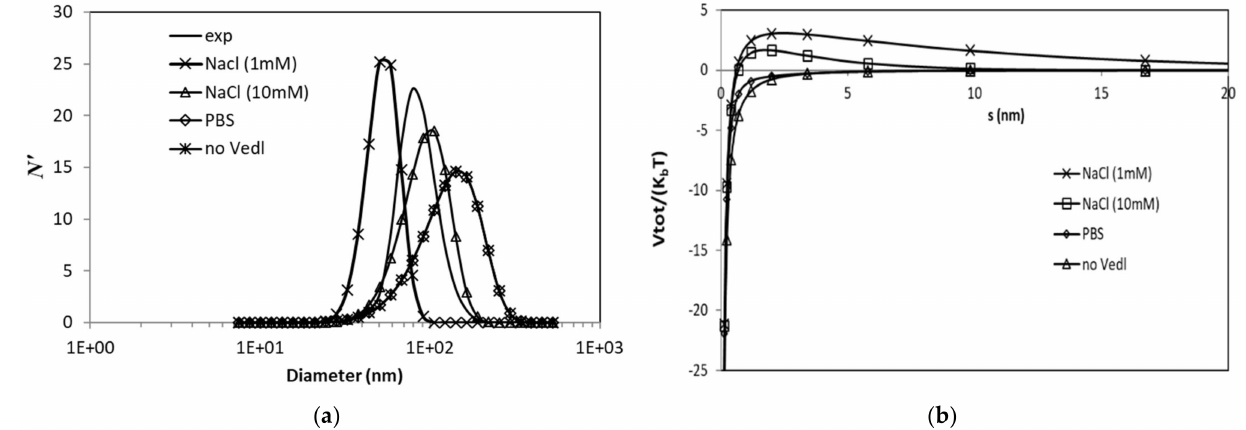
Figure 6. Effects of ionic strength on ( a ) particle size distribution and ( b ) total potential energy.